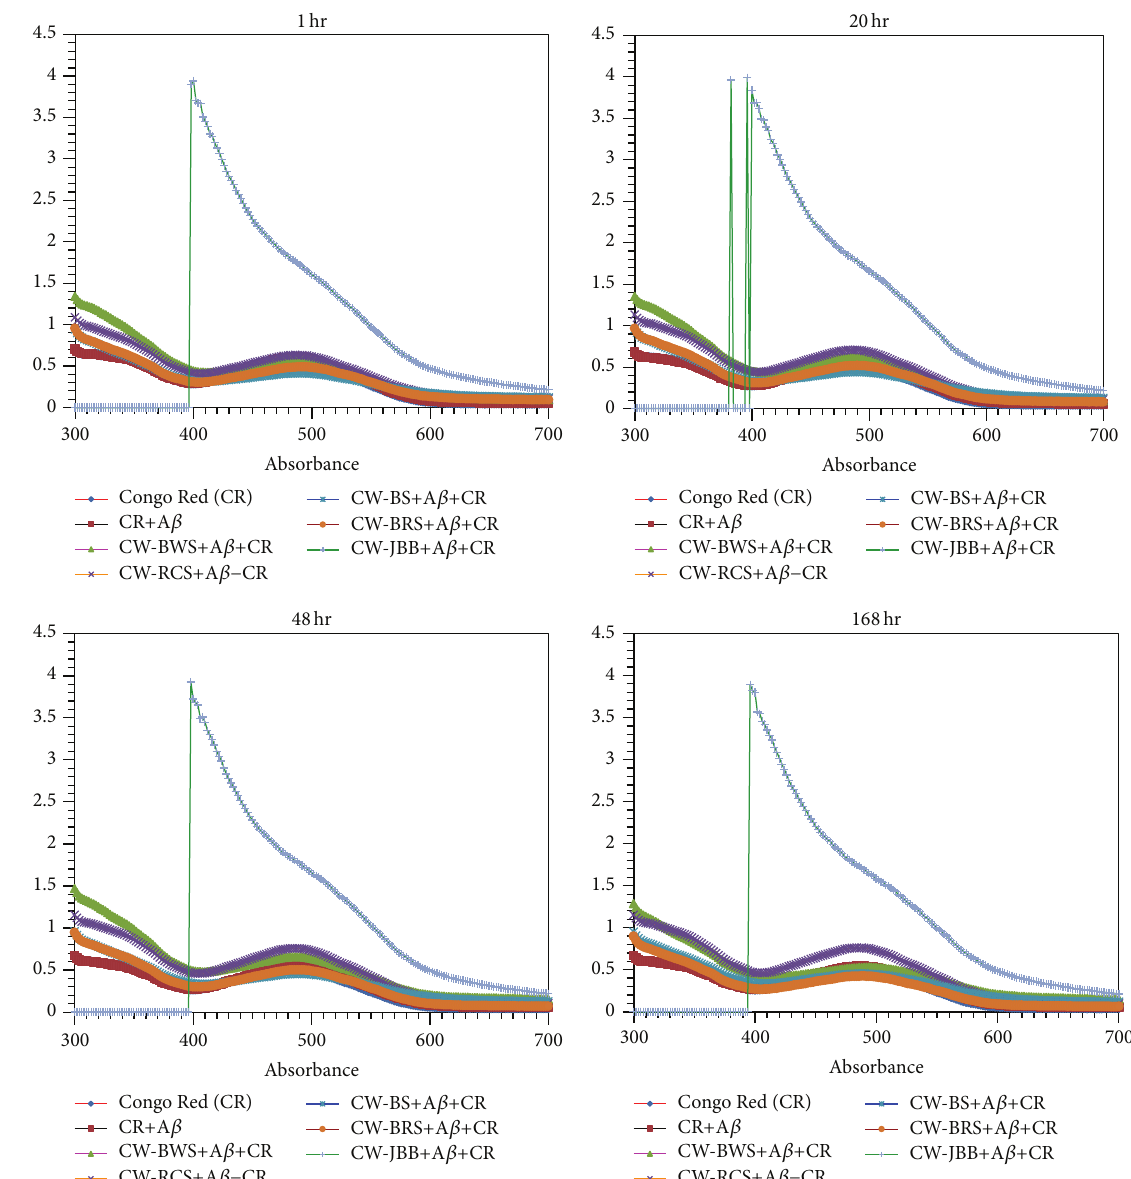
Figure 9: Absorption spectra of 5.0 × 10 −6 M Congo red with and without plant sprouts’ aqueous extracts (PSAE). The colour lines indicate the difference spectrum. The binding of CR was monitored using absorption spectroscopy for up to 168 h.